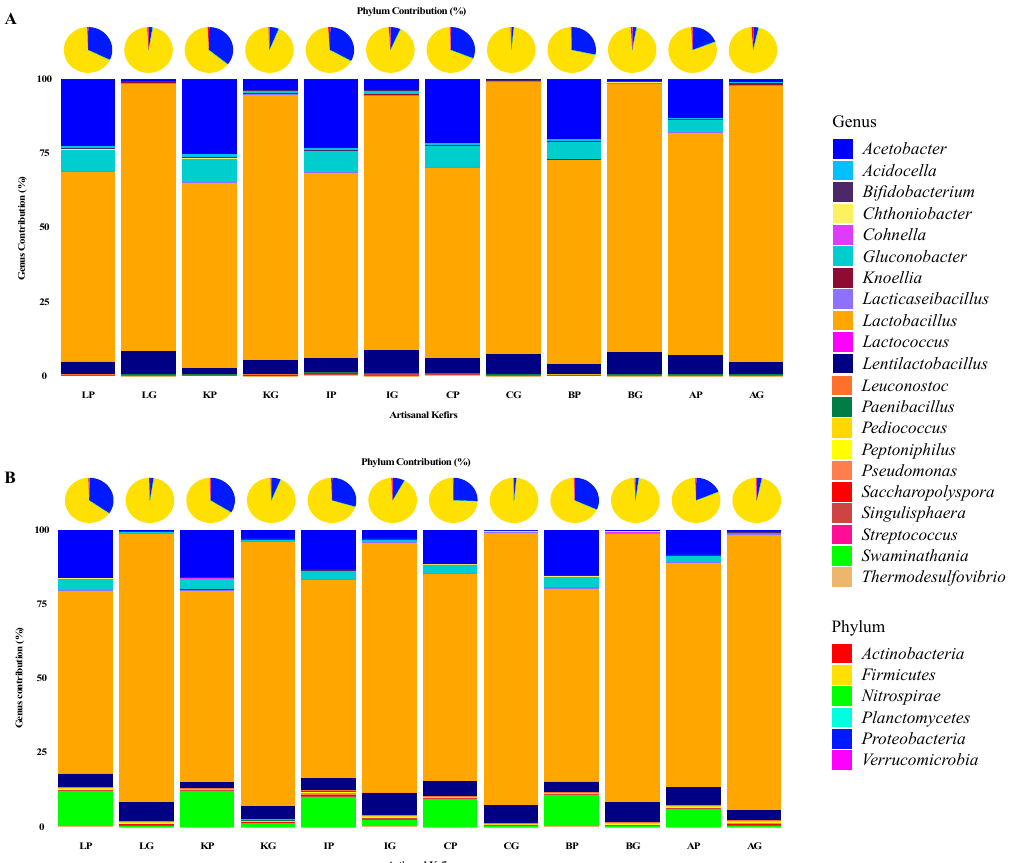
Figure 1. Relative abundances of bacterial phyla (pie charts) and an aggregation of the 21 most abundant bacterial genera (column charts) for the V1–V3 ( A ) and V3–V4 ( B ) regions of the 16S rRNA genes. Kefir product from Lithuania (LP), kefir grains from Lithuania (LG), kefir product from South Korea (KP), kefir grains from South Korea (KG), kefir product from Ireland (IP), kefir grains from Ireland (IG), kefir product from the Caucuses region (CP), kefir grains from the Caucuses region (CG), kefir product from Britain (BP), kefir grains from Britain (BG), kefir product from Fusion Tea (AP, Amazon), kefir grains from Fusion Tea (AG, Amazon).